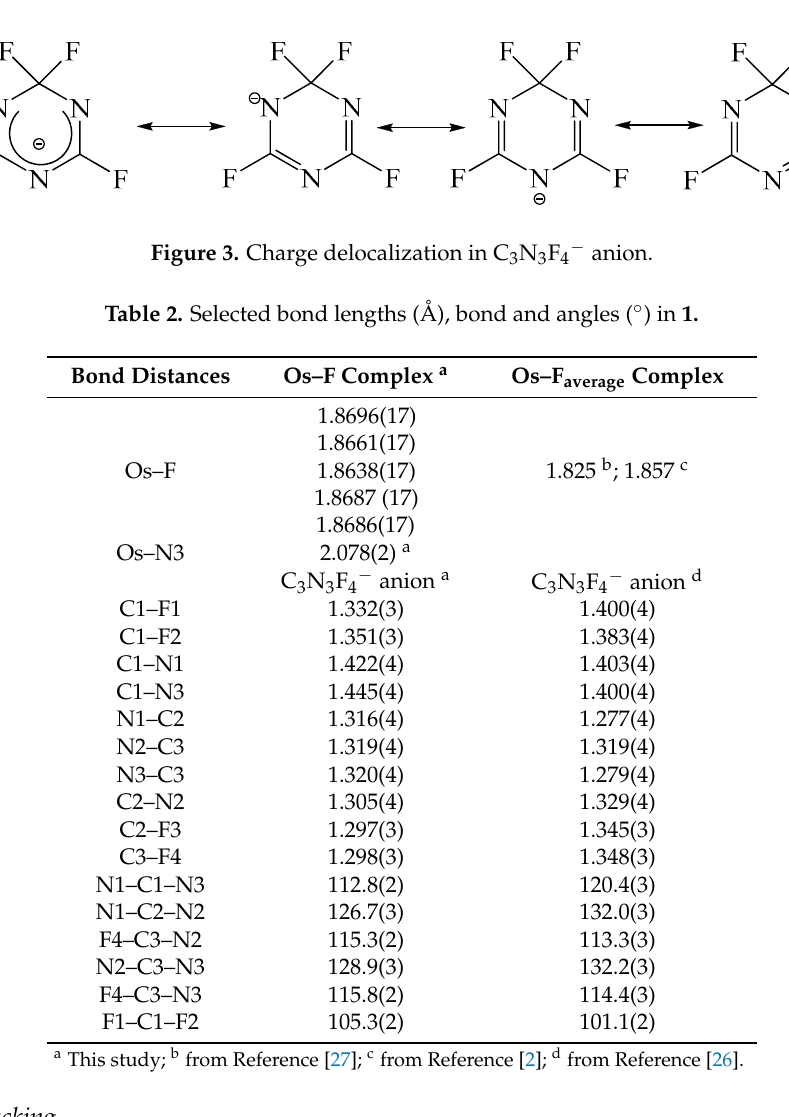
Figure 2. Molecular geometry of complex 1 with atom labeling scheme. Atoms drawn at the 50% probability level.